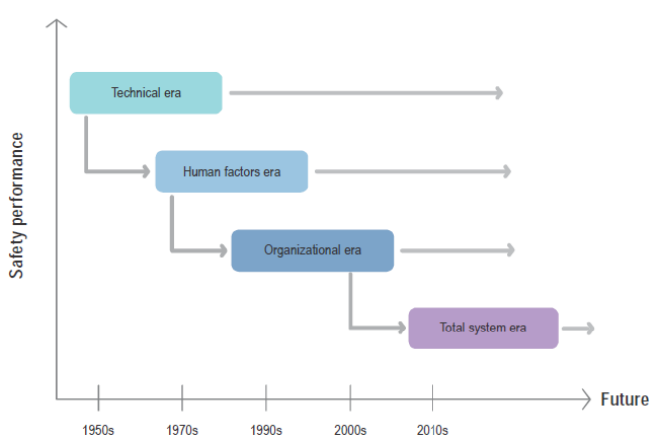
Figure 1 – Flight management system development Рис. 1 – Разработка системы управления